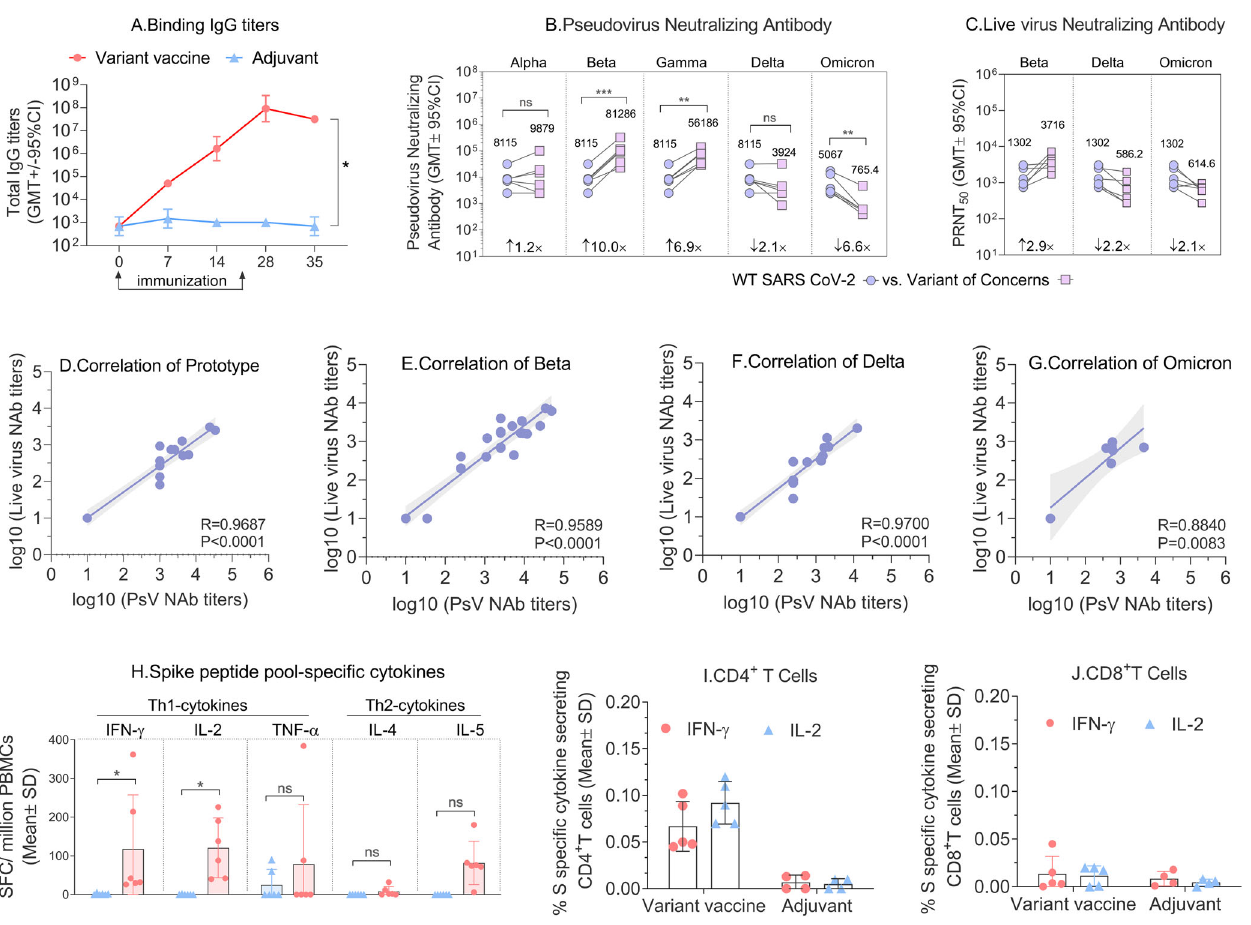
Fig. 7 Immune responses in vaccinated rhesus macaques. A The binding IgG titers (GMT ± 95%CI) were detected at day 0, day 7, day 14, day 28 and day 35. B Changes in pseduovirus neutralizing antibody titers against prototype SARS-CoV-2 and all fi ve variant of concerns. Day 35 sera of NHP were used following two immunizations with variant vaccine ( N = 6). C Cross-reactivity of live virus with SARS-CoV-2 prototype, Beta and Delta strains. D – G Correlation between live virus-neutralizing antibody titers and pseudovirus-neutralizing antibody titers of prototype, Beta, Delta and Omicron strains. Three important parameters from the correlates analysis shown as R -value, P -value and 95% con fi dence intervals. Shaded areas represent 95% con fi dence intervals. H Th1-associated cytokines (IFN- γ , IL-2, TNF- α ) and Th2-associated cytokines (IL-4, IL-5) secreted from vaccinated monkeys were detected by ELISPOT, data are shown as the Mean ± SD. I % S seci fi c cytokines secreting CD4 + T cells. J % S seci fi c cytokines secreting CD8 + T cells, data are shown as the Mean ± SD. Note: * p < 0.05, ** p < 0.01, *** p < 0.001; ns, not signi fi cant